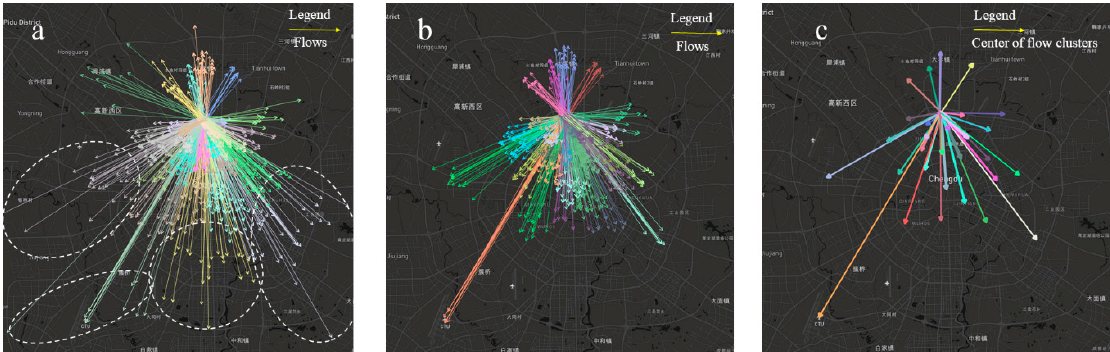
Figure 9. Clustering results by the spatial version of TOCOFC: ( a ) Clusters; ( b ) Clusters (the parameter disLimit has a limitation); ( c ) Centers of the OD flow clusters.